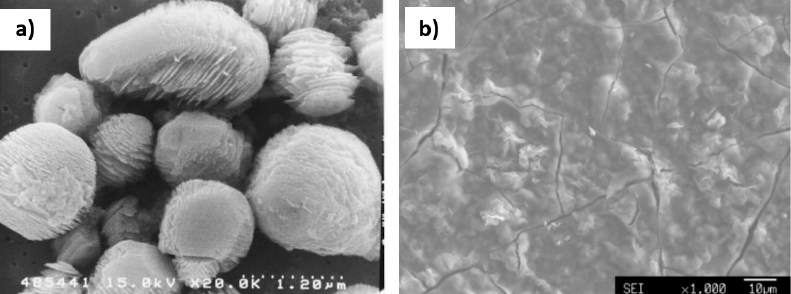
Figure 5. ( a ). Ce-oxide particles extracted by 10% AA at 700 C. It can be seen that the surface of the particles is dissolved. ( b ) Surface of film filter with particles after extraction by 2% TEA at 500 C. It can be seen that particles are almost undetectable due to the precipitated Cr-rich compound covering them [66]. Copyright © 2009 Verlag Stahleisen GmbH, Düsseldorf.